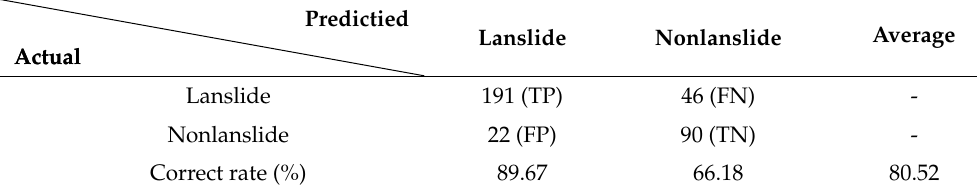
Table 5. Confusion matrix for the case of the Putunpunas River